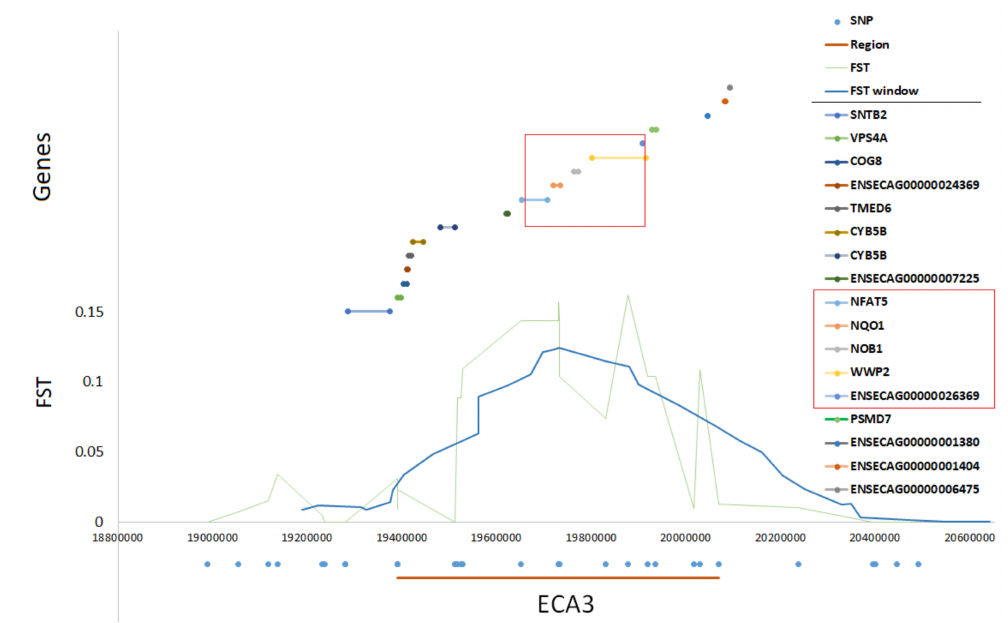
Figure 5. Detailed view of the divergently-selected region on ECA3. Region position, SNP positions, F ST and window averaged F ST values, and gene positions directly at the selected region are plotted.